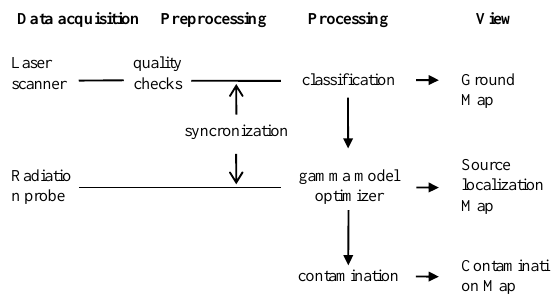
Figure 5. Scheme of process followed to localize a radiation source on